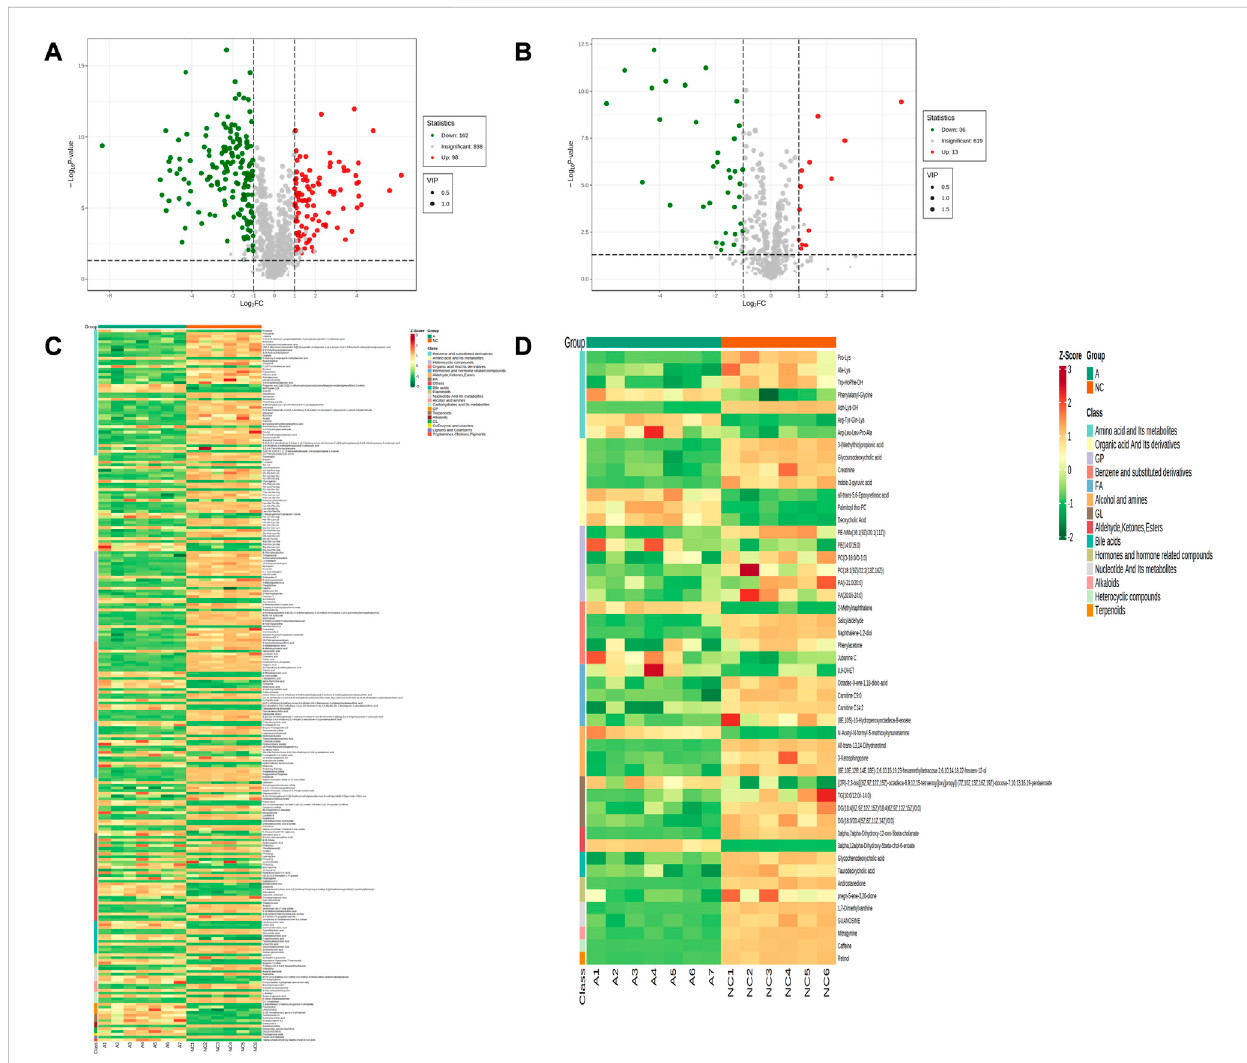
FIGURE 4 Expression of differential metabolites in NC vs. group A. (A) volcano plot of differential metabolites under anionic conditions; (B) volcano plot of differentialmetabolites undercationicconditions; (C) heatmapofdifferentialmetaboliteexpressionbetweensamplesunderanionicconditions; (D) heat map of differential metabolite expression between samples under cationic